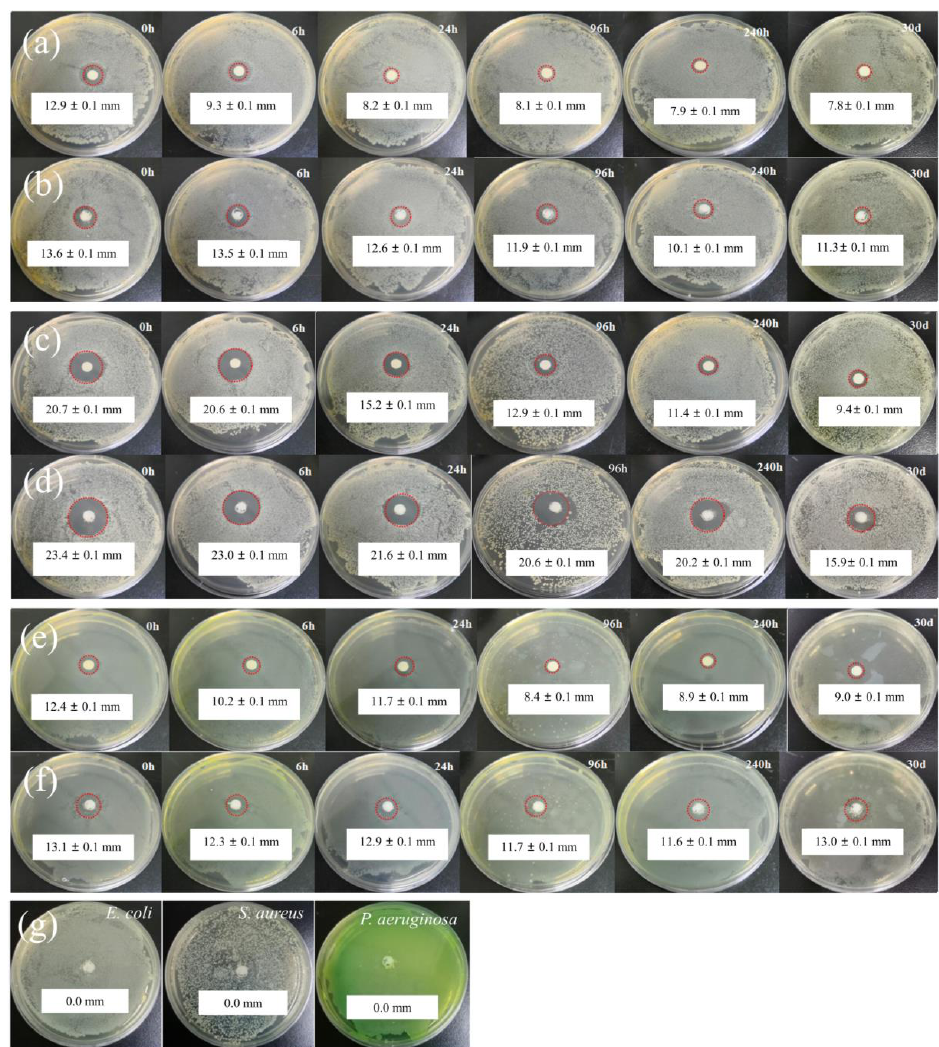
Figure 8. The inhibition zone of CEO ( a ) and CEO−SNP ( b ) on E. coli at different release times (0 h, 6 h, 24 h, 96 h, 240 h and 30 d). Inhibition zone of CEO ( c ) and CEO−SNP ( d ) on S. aureus at different release times (0 h, 6 h, 24 h, 96 h, 240 h and 30 d). Inhibition zone of CEO ( e ) and CEO−SNP ( f ) on P. aeruginosa at different release times (0 h, 6 h, 24 h, 96 h, 240 h and 30 d). Inhibition zone of SNP ( g ) on E. coli , S. aureus and P. aeruginosa .